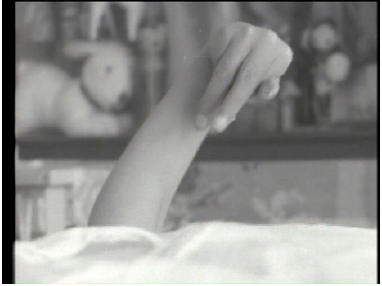
Figure 1. A right arm raised in the air. Still from The Children of Minamata are Living (1965), director Tsuchimoto Noriaki.